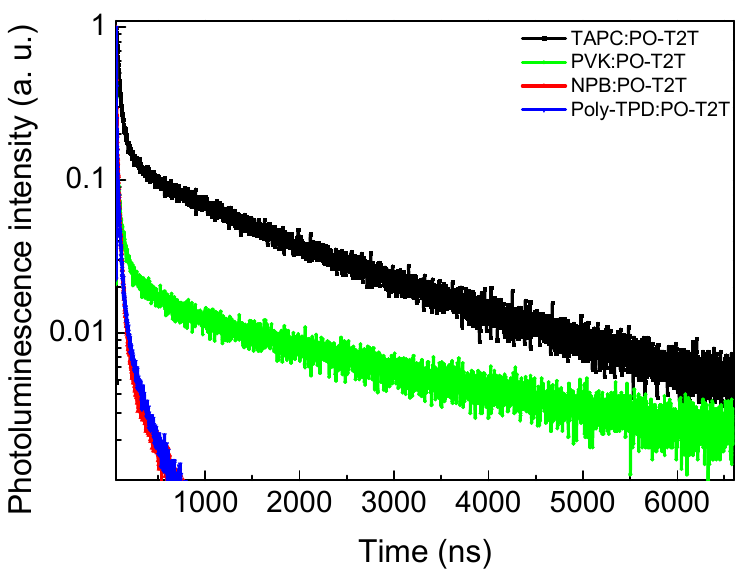
Figure 4. Room-temperature photoluminescence decay of investigated exciplex blends ( λ exc = 330 nm). All exciplexes are formed with a respective donor and POT2T as an acceptor. Donor:acceptor ratio is 2:1. Decays were recorded in atmosphere at 295 K.